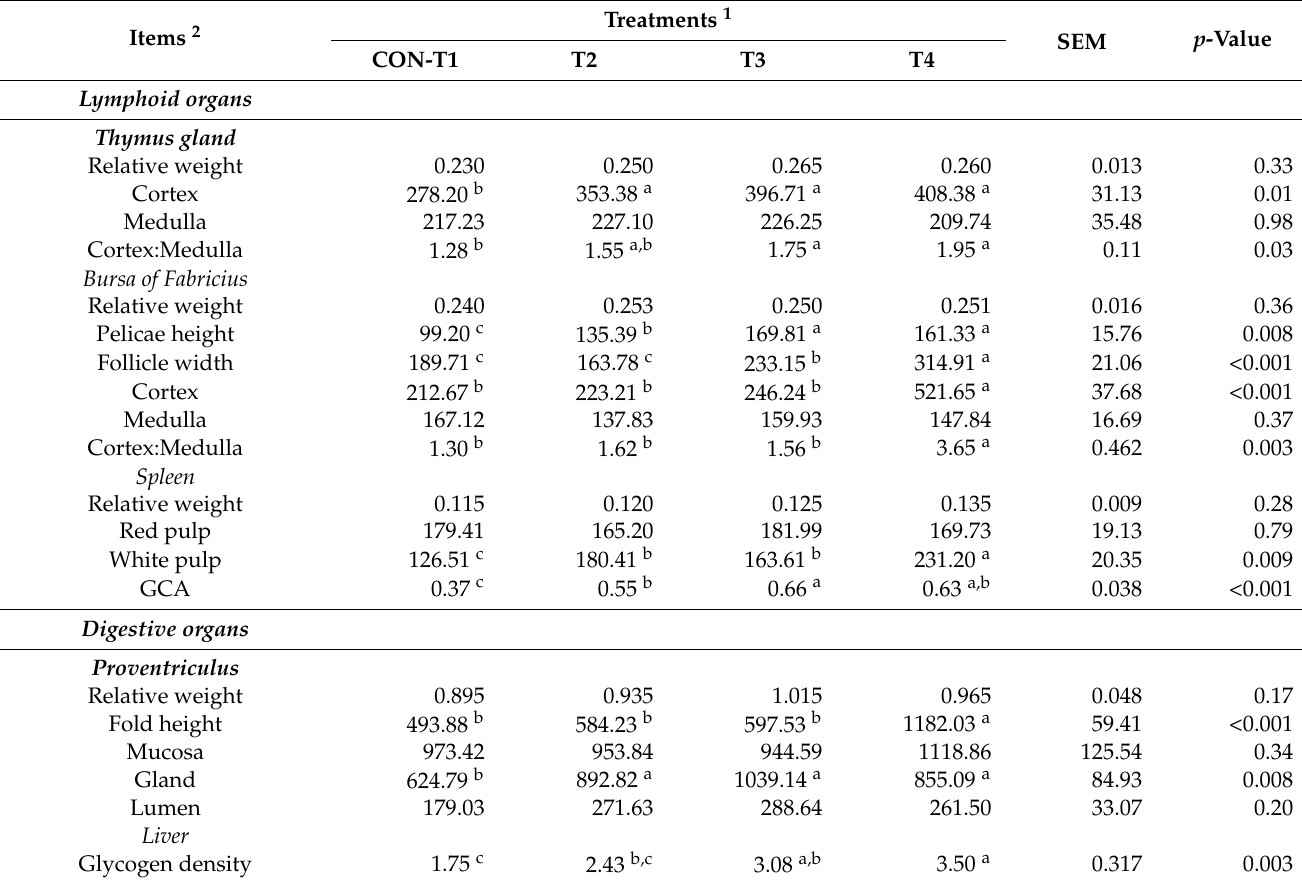
Table 3. Effect of early nutrition with different diets post-hatching (PH) on the relative weights (% of live body weight) and histomorphology of lymphoid organs and proventriculus ( µ m) of layer-type chicks at day 28 of